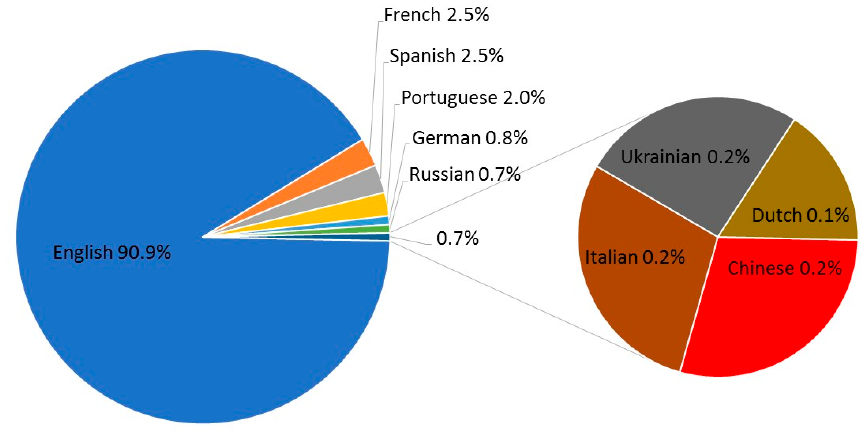
Figure 2. Language distribution of worldwide of scientific output on labour relations.